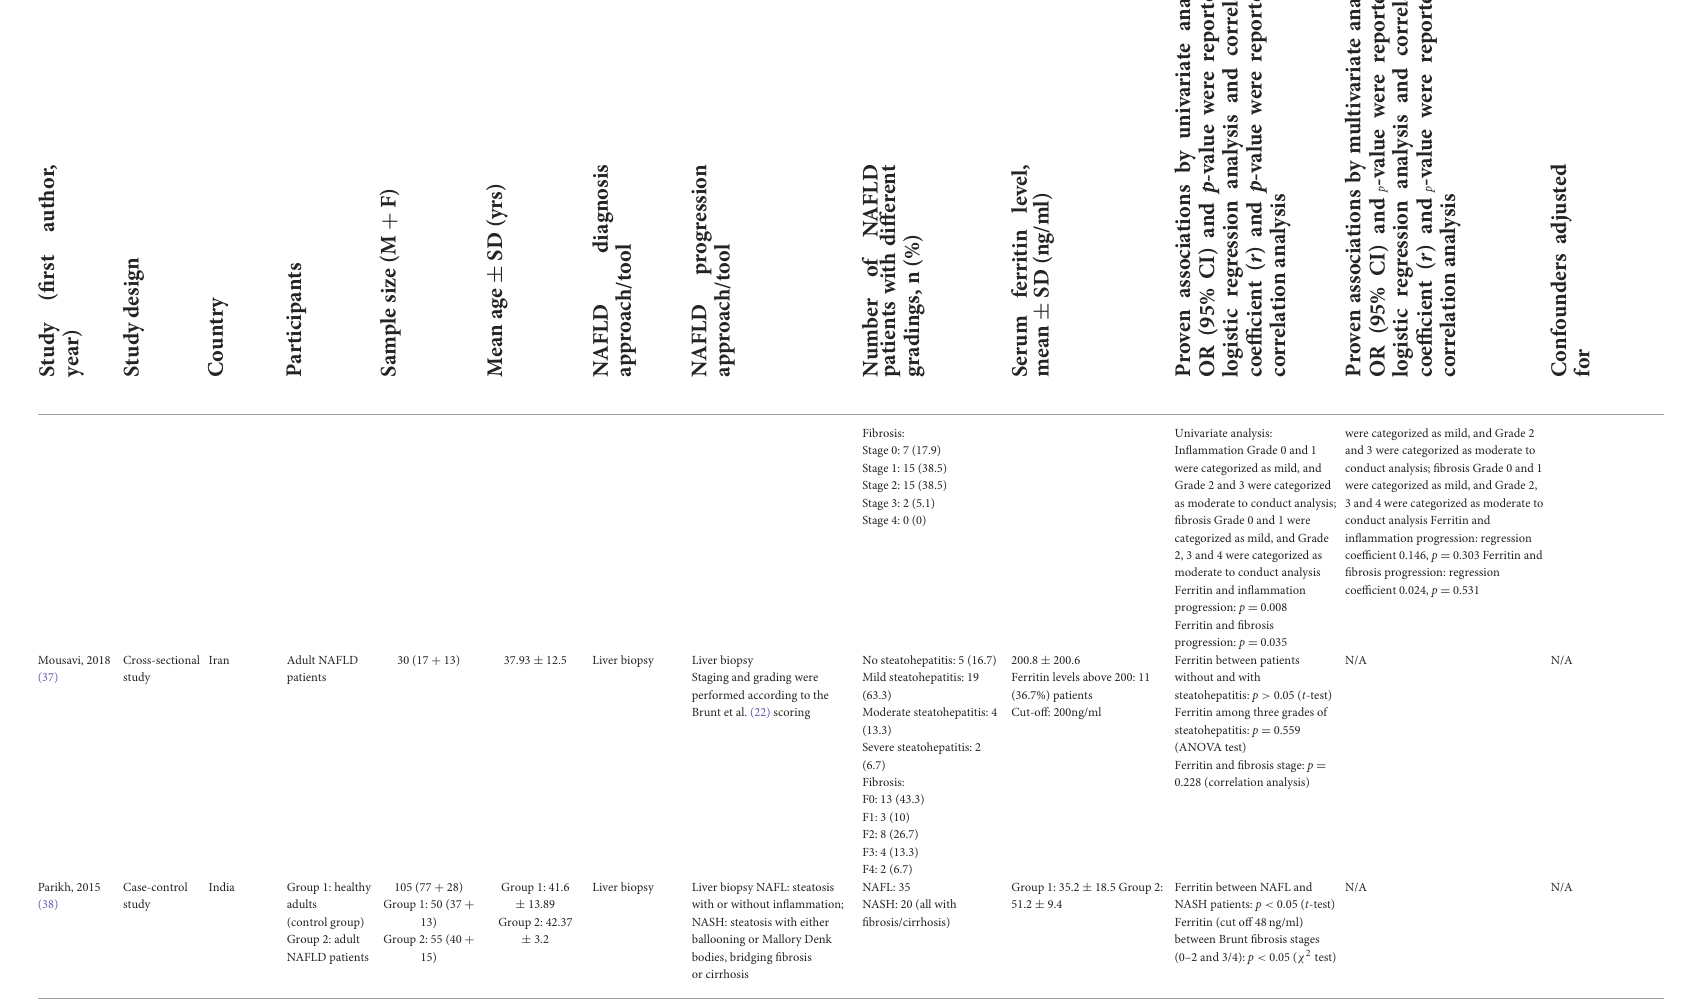
Group1:35.2 ± 18.5Group2: 51.2 ± 9.4